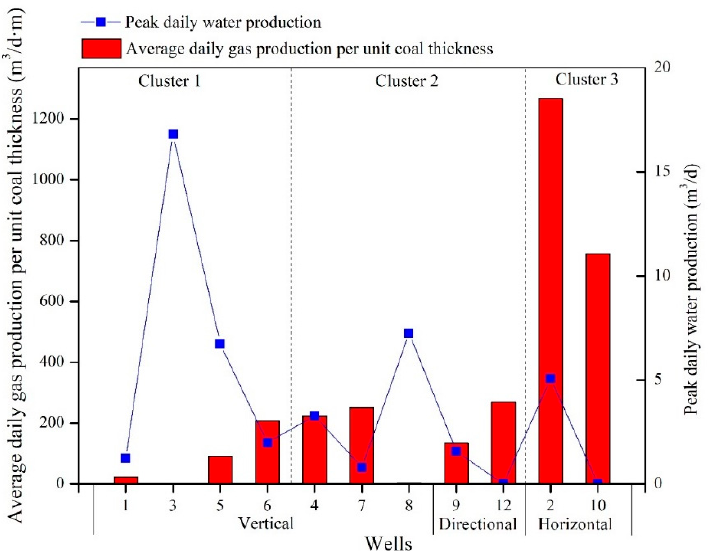
Figure 10. Gas and water production of the CBM wells with the three clusters.